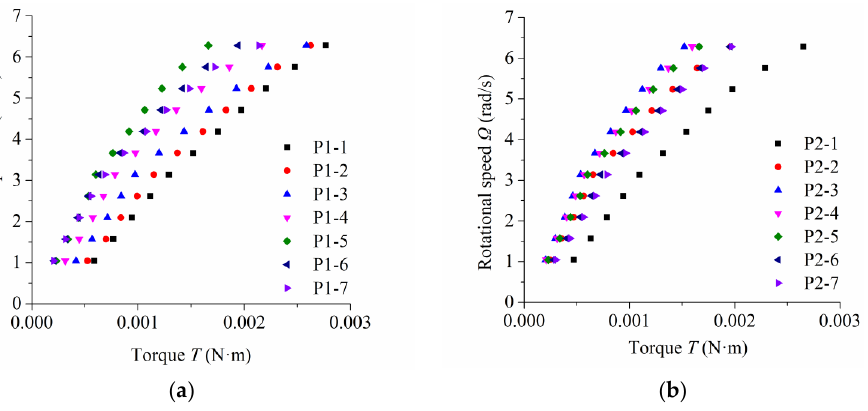
Figure 3. Relationship between rotational speed and torque of pastes in a steady flowing state. ( a ) P1; ( b ) P2.